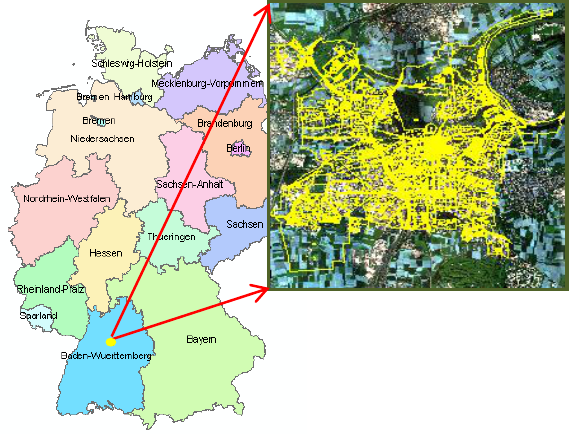
Figure 1 . Research area,